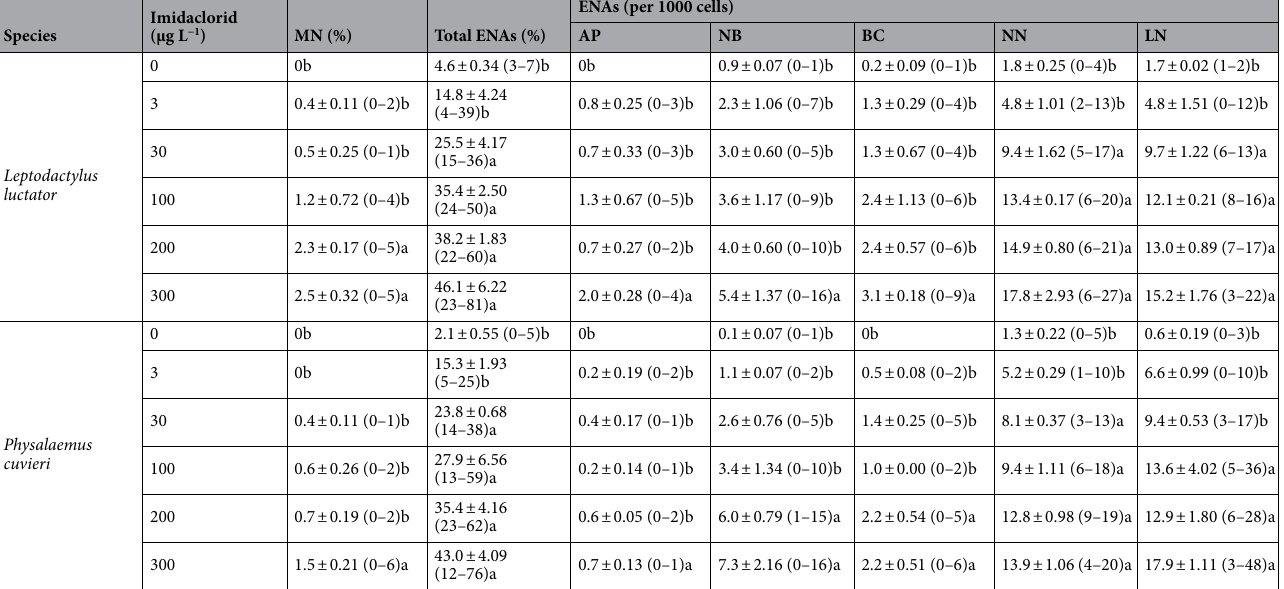
Table 1. Frequency of micronuclei (MN, %), Erythrocyte Nuclear Abnormalities (ENAs, %), apoptosis (AP, ‰), nuclear bubbles/buds (NB, ‰), binucleated cells (BC, ‰), notched nuclei (NN, ‰), and lobed nuclei (LN, ‰) in the Leptodactylus luctator and Physalaemus cuvieri tadpoles exposed to different concentrations of imidacloprid for 168 h. The values are given as the mean ± SEM (minimum–maximum ENAs observed in 1000 cells; n = 3). Pairs of values followed by different letters in the same line are significantly different according to Dunnett’s test ( p < 0.05).